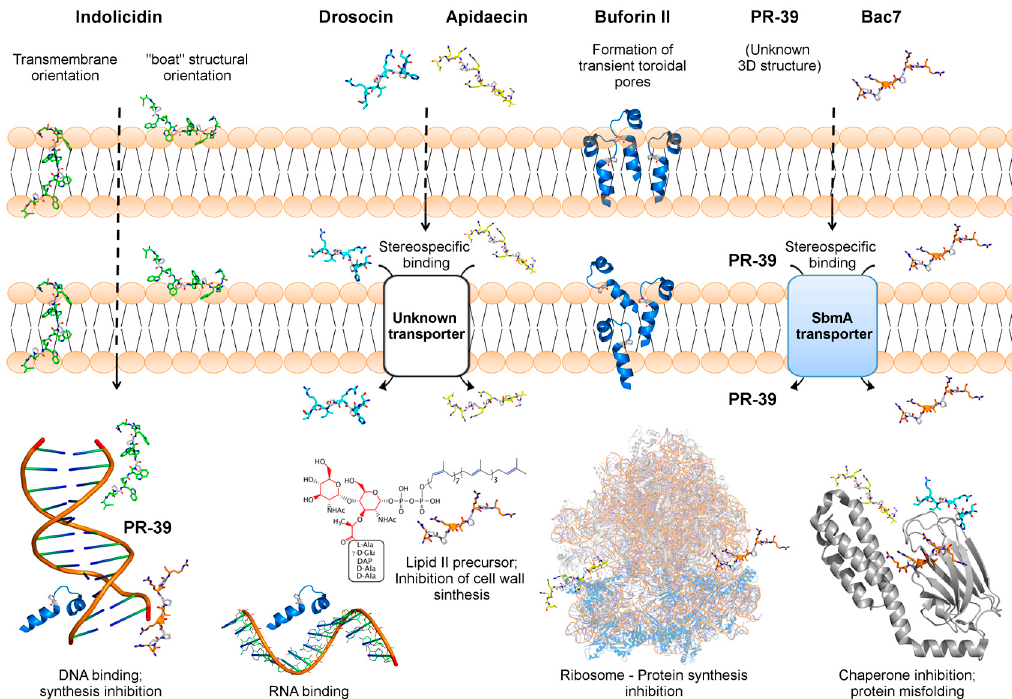
Figure 1. Representation of the membrane translocation mechanisms and intracellular targets for indolicidin (green sticks—PDB 1g8c), PR-39 (name only), bac7 (orange sticks—PDB: 5f8k), apidaecin (yellow sticks—PDB: 5o2r), drosocin (cyan sticks—PDB: 4ezr) and buforin II (blue—PDB: 4kha).